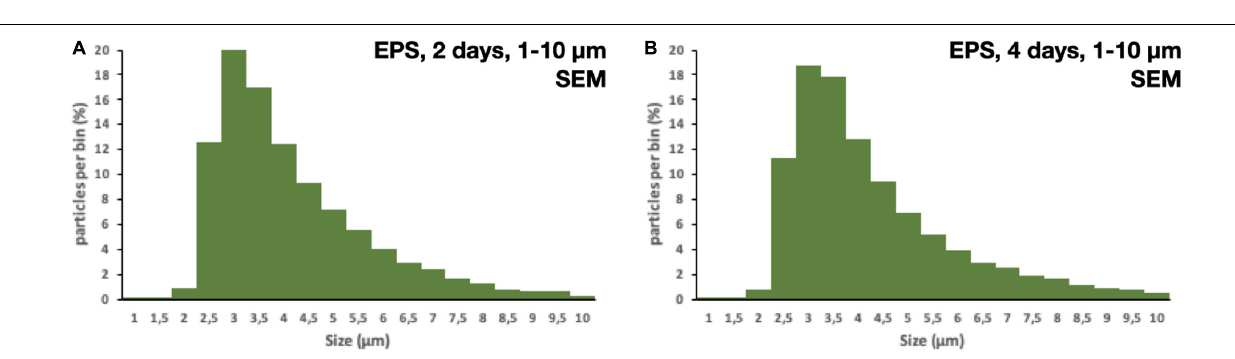
FIGURE 5 | Size distribution of particles collected on the 1 µ m filter after (A) 2 days of fragmentation and (B) 4 days of